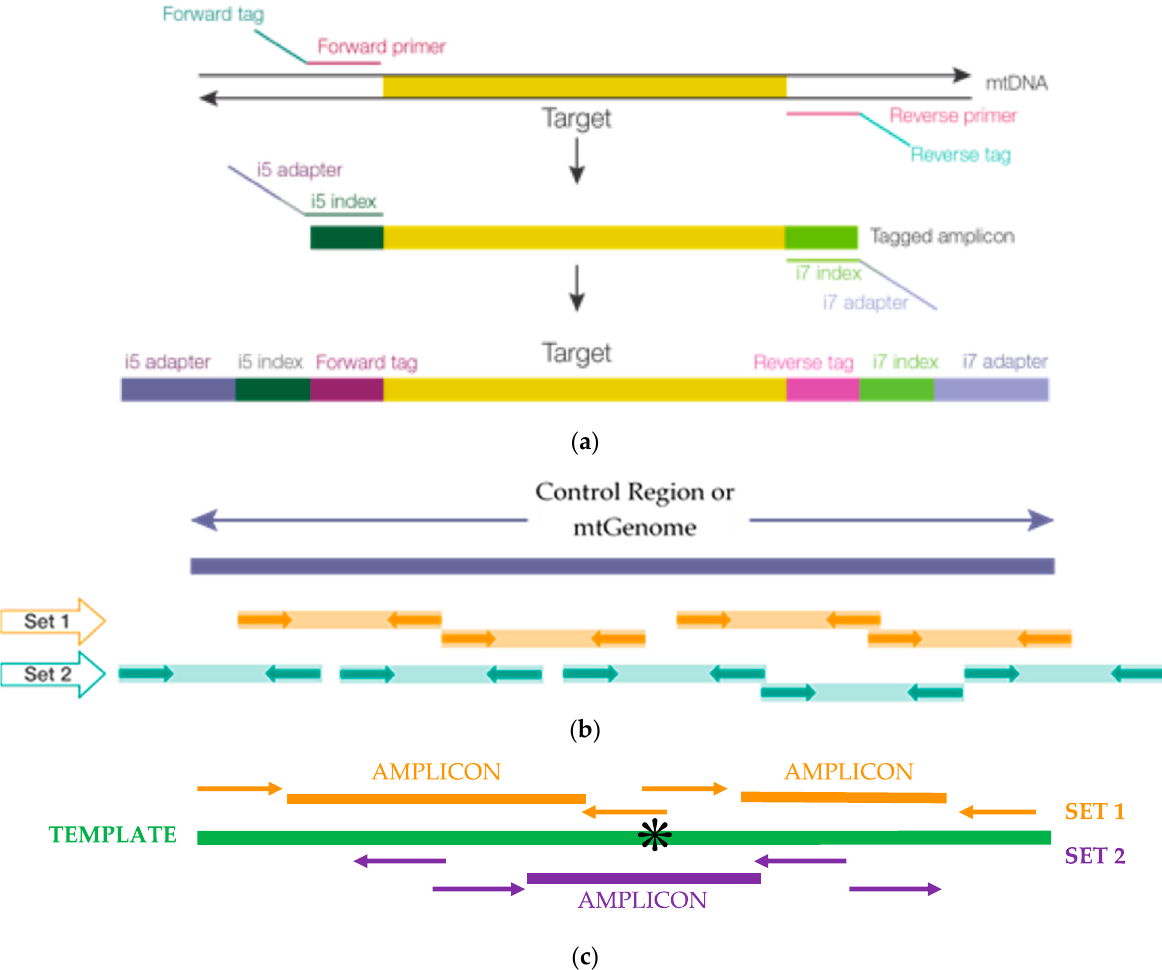
Figure 1. Schematic of ForenSeq mtDNA control region and mtDNA whole-genome library preparation design and workflow. ( a ) PCR-based target enrichment and tagging create DNA templates consisting of regions of interest flanked by universal primer sequences. Index adapters then attach to the tags. Resultant paired-end, dual-indexed, tiled libraries are amplified, purified, and pooled into one tube for MiSeq FGx sequencing and analysis with ForenSeq UAS or other software, ( b ) ForenSeq protocol divides each DNA sample into two PCRs with separate primer sets (set 1, set 2) in a tiled strategy that promotes efficient amplification of overlapping amplicons to allow complete coverage and reduces unintended byproducts, ( c ) the two-PCR approach can facilitate confirmation of variant(s) that reside under a primer: when a primer-binding site mutation exists under a primer in one primer set (asterisk under a set 1 primer in this diagram), then that variant can be reliably detected in amplicons extended from the companion primer set (set 2). Alternative approaches can more frequently produce ambiguity regarding primer sequences versus variants.